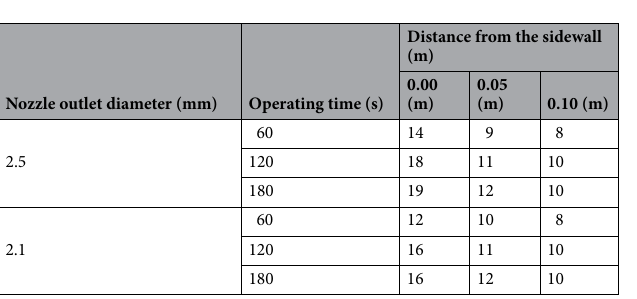
Figure 16. Outline of the nozzle placement during the hydro-mining tests.